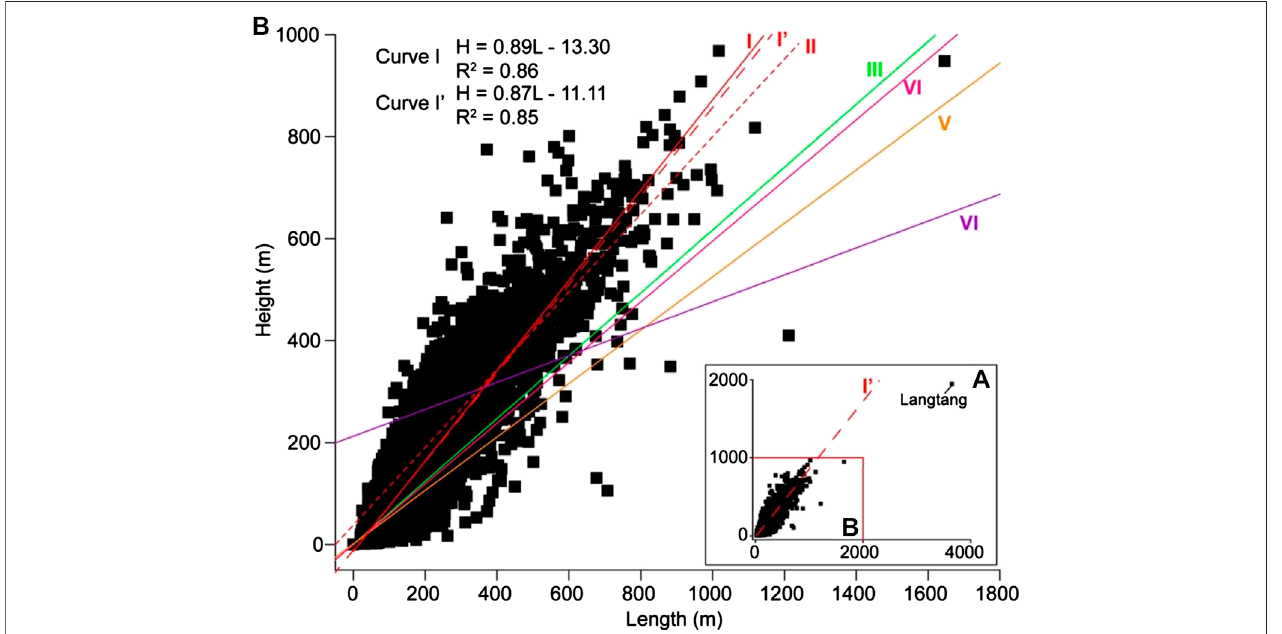
FIGURE 11 | Fitting relationships oflandslide length and height. (A) Fitting plot with the 22,914 landslides. (B) Fitting plots for the 2015 Gorkha earthquake (curve I for landslides (22,913) in Dataset 1 without the Langtang avalanche, curve I ’ for all landslides (22,914) in Dataset 1 and curve II for landslides (2,059) in Dataset 2) and other existing research (curves III – VI are for landslides in areas related to Minxian, Haiti, Hongkong and Wenchuan cases). Table 3 provides further details.